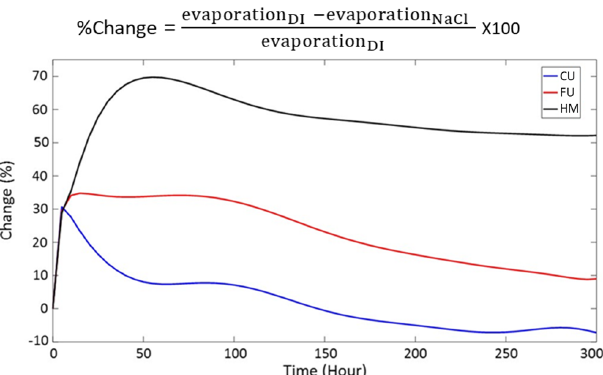
Figure 10. Relative difference in cumulative evaporation between saline and non-saline soil water solution over time, for the tilled (CU), Homogeneous-Mixed (HM), and compacted (FU)